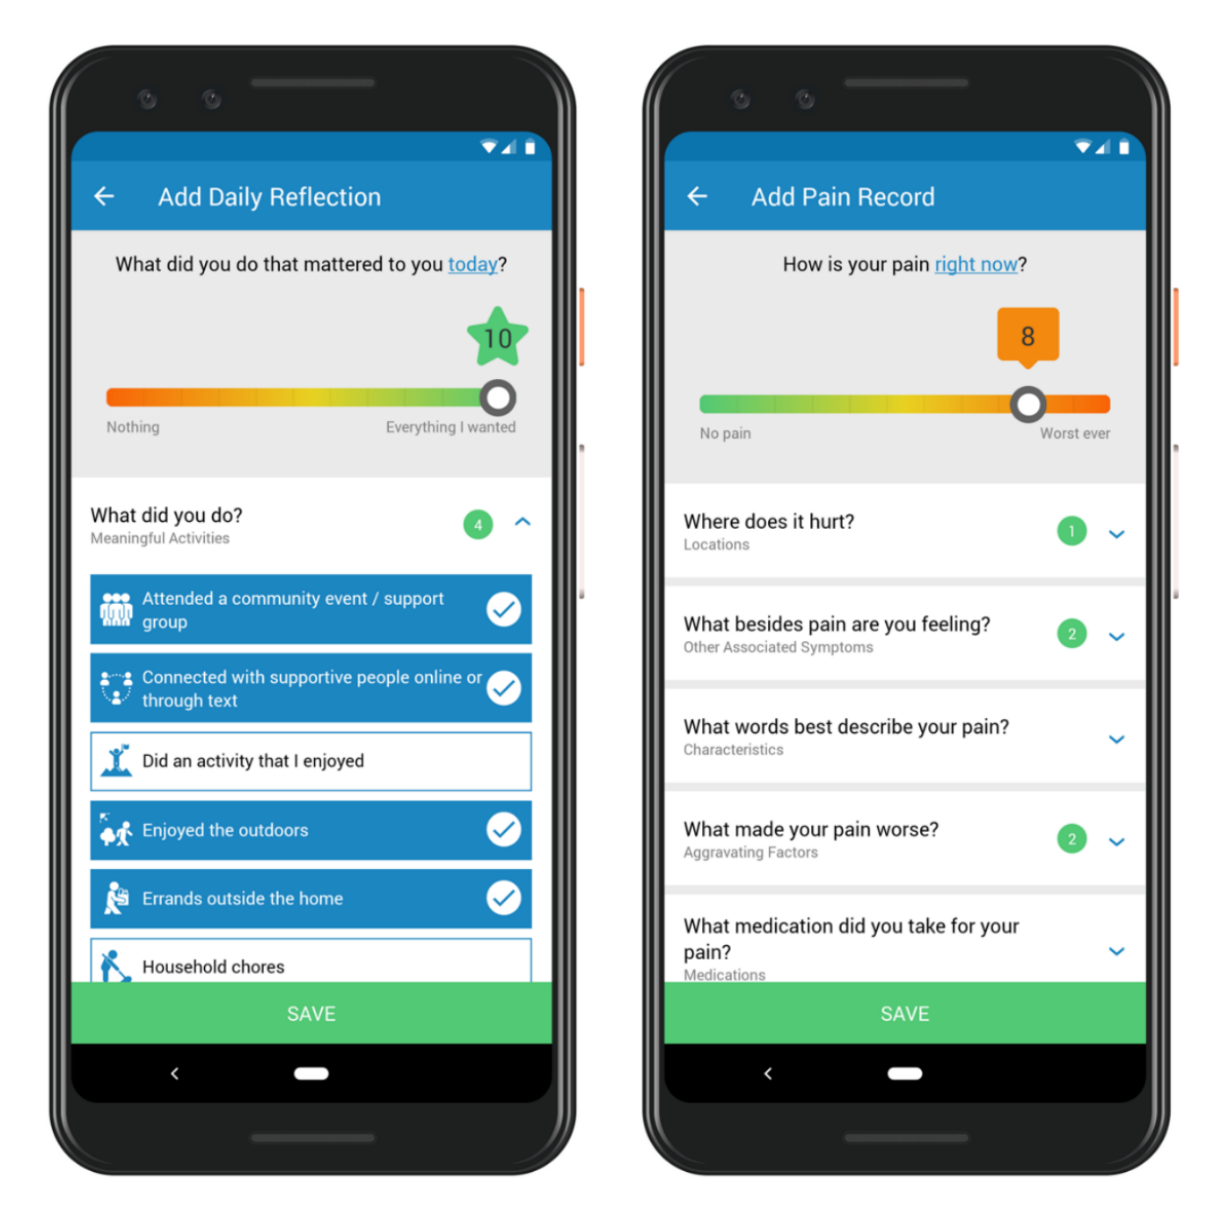
Figure 1. Screenshots of the screens used by Manage My Pain to collect patient-reported